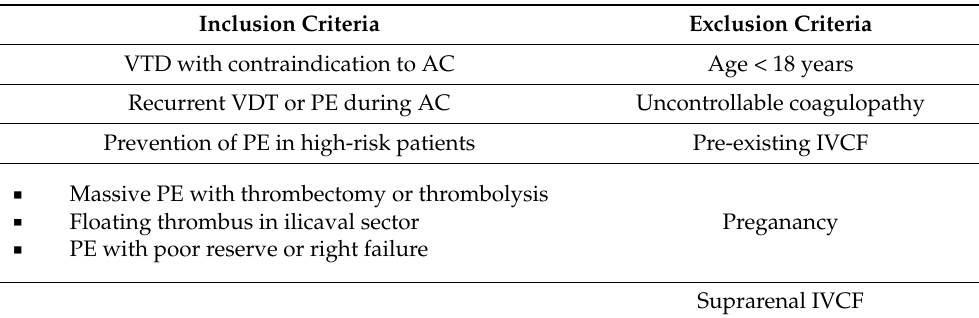
Table 1. Baseline participant characteristics and filter release. BMI: body mass index, IVC: inferior vena cava, PE: pulmonary embolism, AC: anticoagulation.